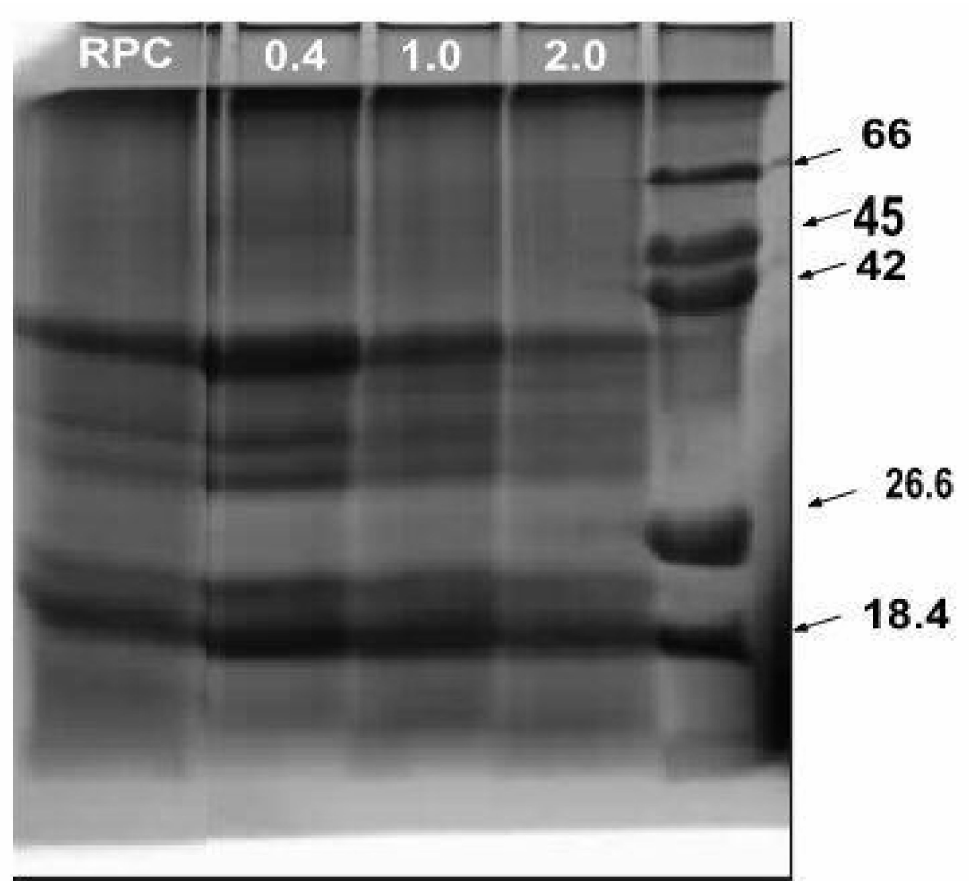
Figure 5. SDS-PAGE of the native and acetylated RPC. RPC—rice protein concentrate; 0.4, 1.0, 2.0—rice protein preparations after acetylation conducted with different concentrations of